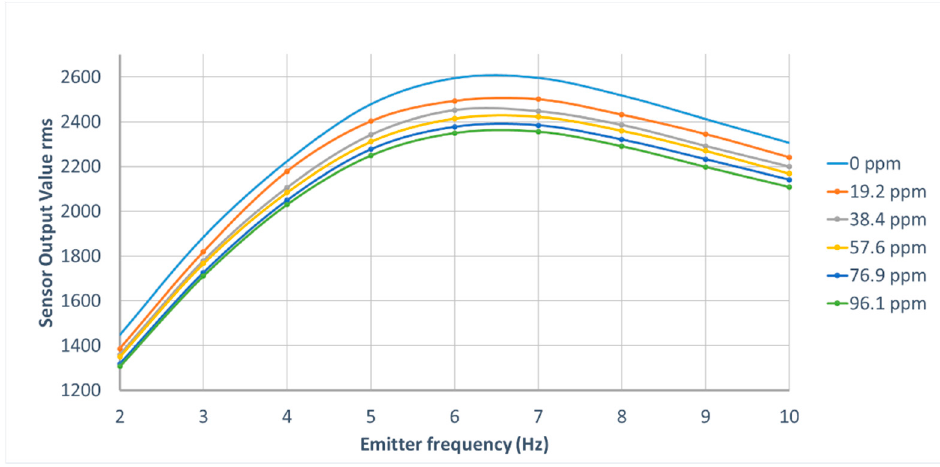
Figure 3. Variations of detector output values against the running frequency of the IR emitter .